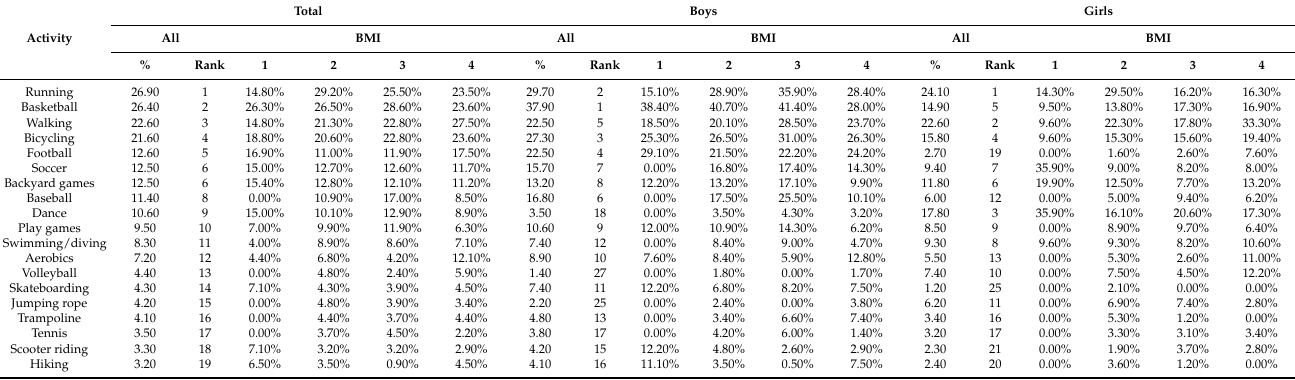
Table 6. Ranking of PA outside school in 2012 (BMI: 1 = Underweight, 2 = Normal weight, 3 = Overweight, 4 = Obese); NA = No participation by boys or girls in this specific